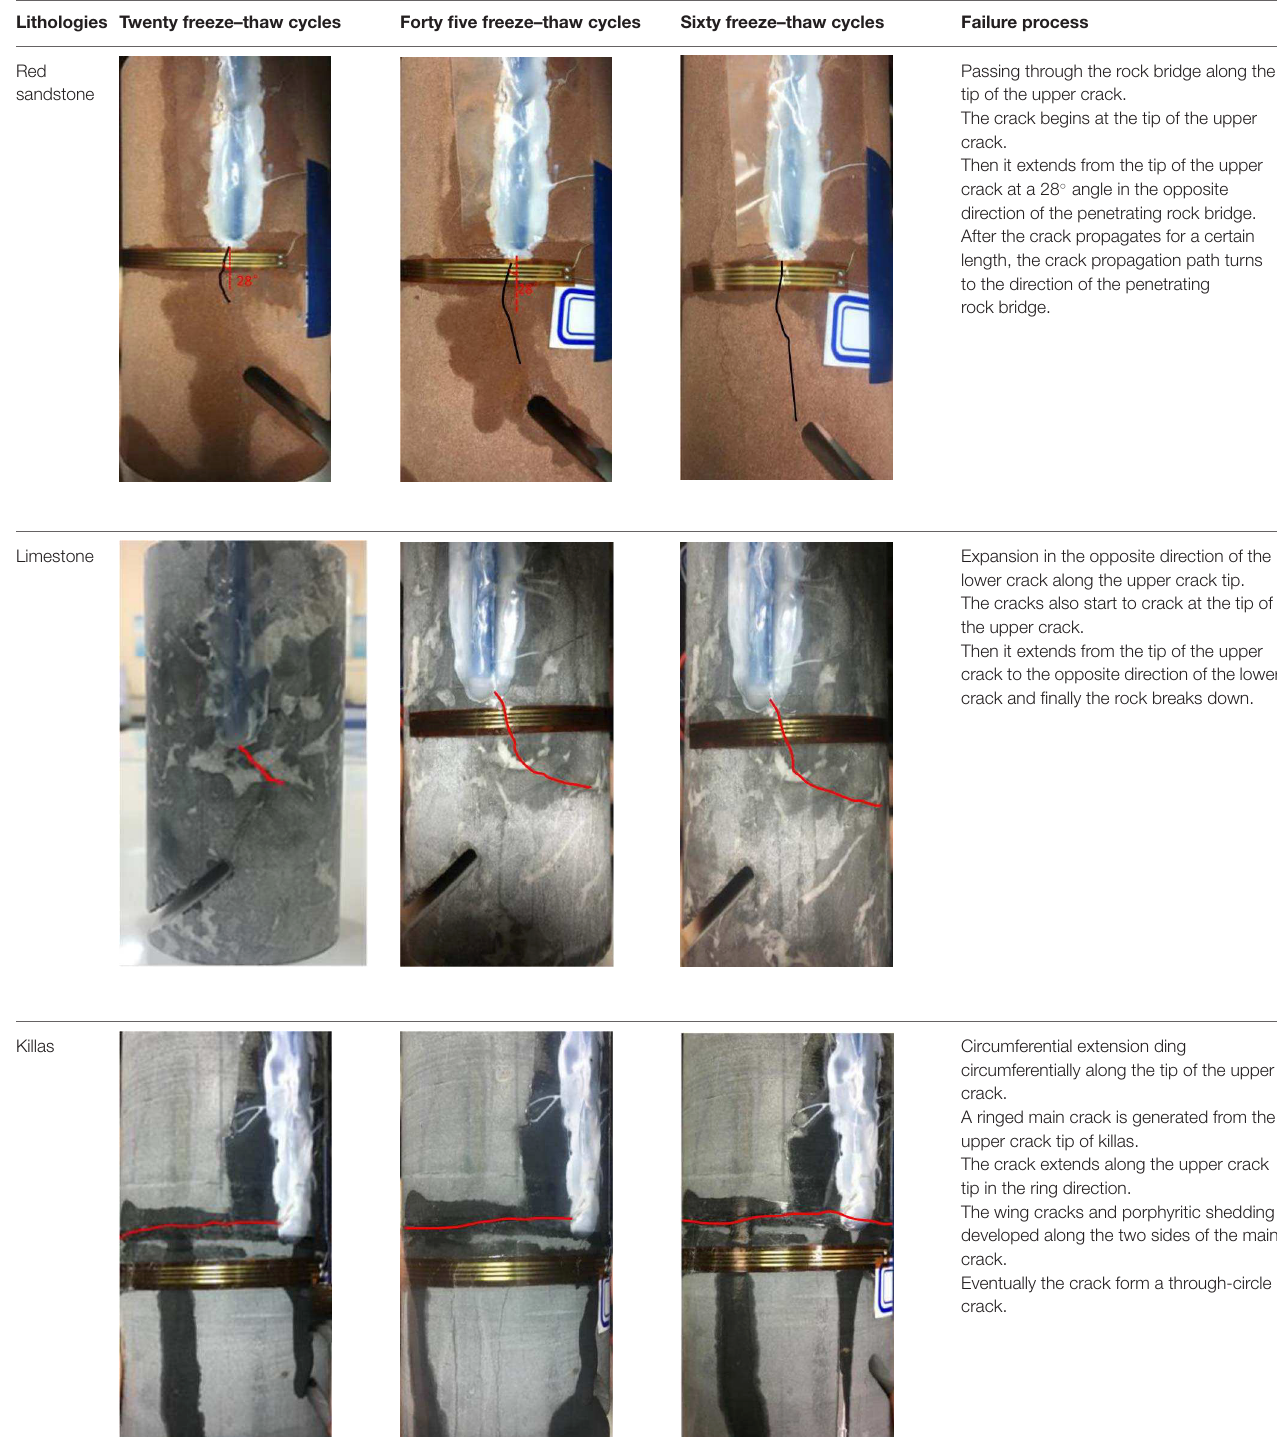
TABLE 2 | Freeze–thaw failure processes with different